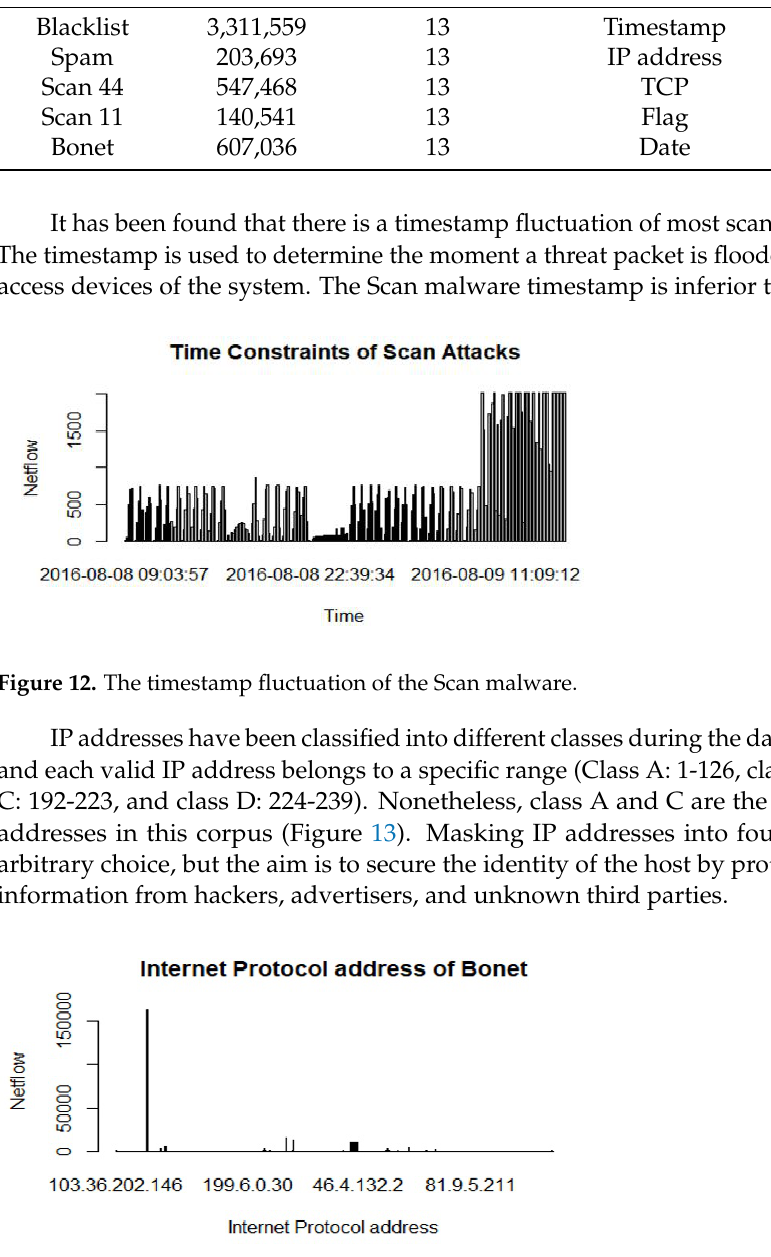
Figure 13. Imbalanced IP addresses of the Bonet